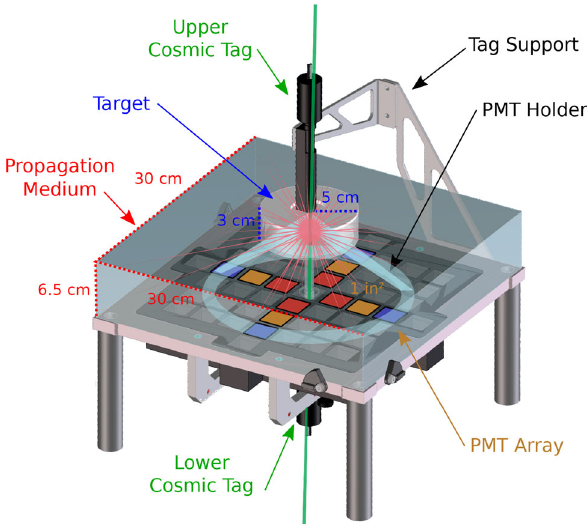
Fig. 1 CHESS schematic. The PMT array can hold up to 53 PMTs; the 12 slots occupied for this study are color coded by radius: red and orangeforthosehitprimarilybyscintillationphotons,andblueforthose that detect the Cherenkov